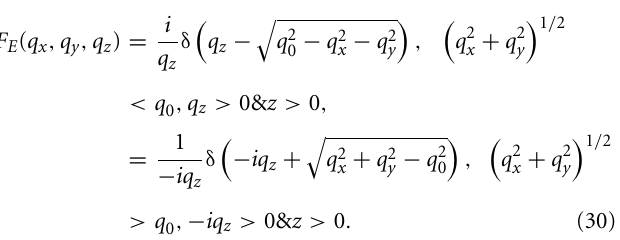
FIGURE 2 | (A) The Green function transform for forward propagating (non-evanescent) waves for observation points z > 0 lies on a hemispherical shell. It consists of contributions from both the homogeneous and